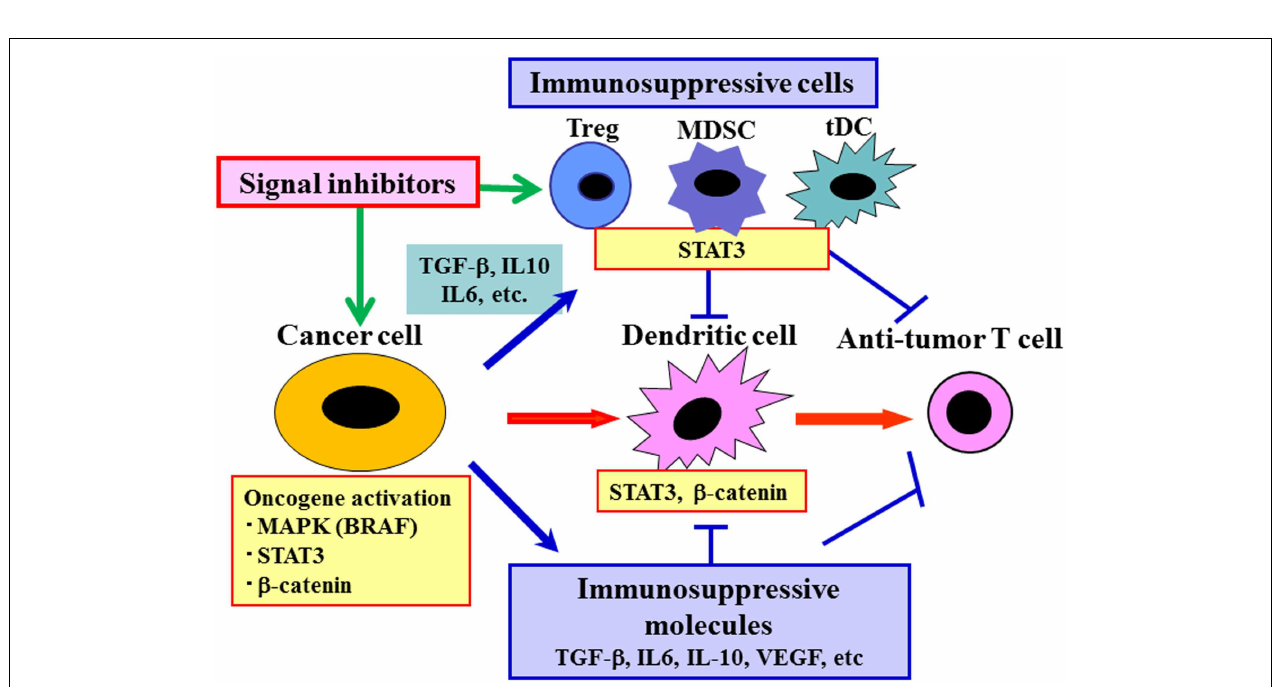
antigens, enhancement of DC function, activation and expansion of anti-tumorT cells as well as reversal of cancer-induced immunosuppression ( Figure 2 ) is important for development of effective cancer immunotherapy.